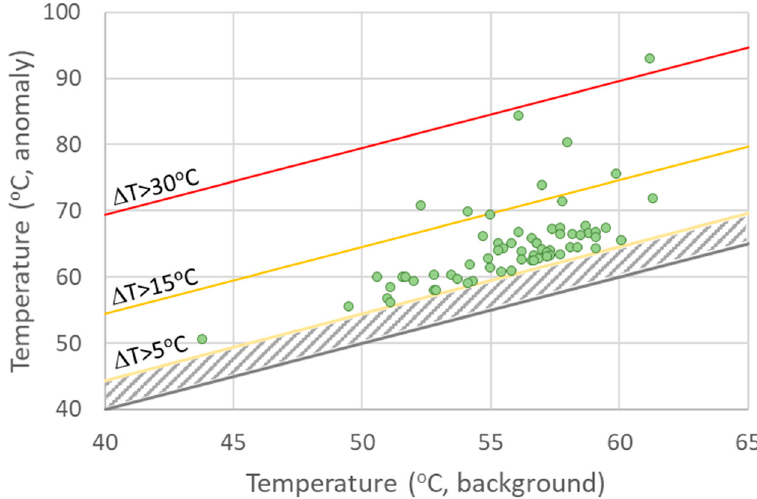
Figure 12. Cross-correlation of anomaly and background temperatures for each module (which are represented by a single green point). The points located within the yellow bands indicate light and medium failures, those points above the red line indicate a grave failure. The grey stripped area is considered normal operation.